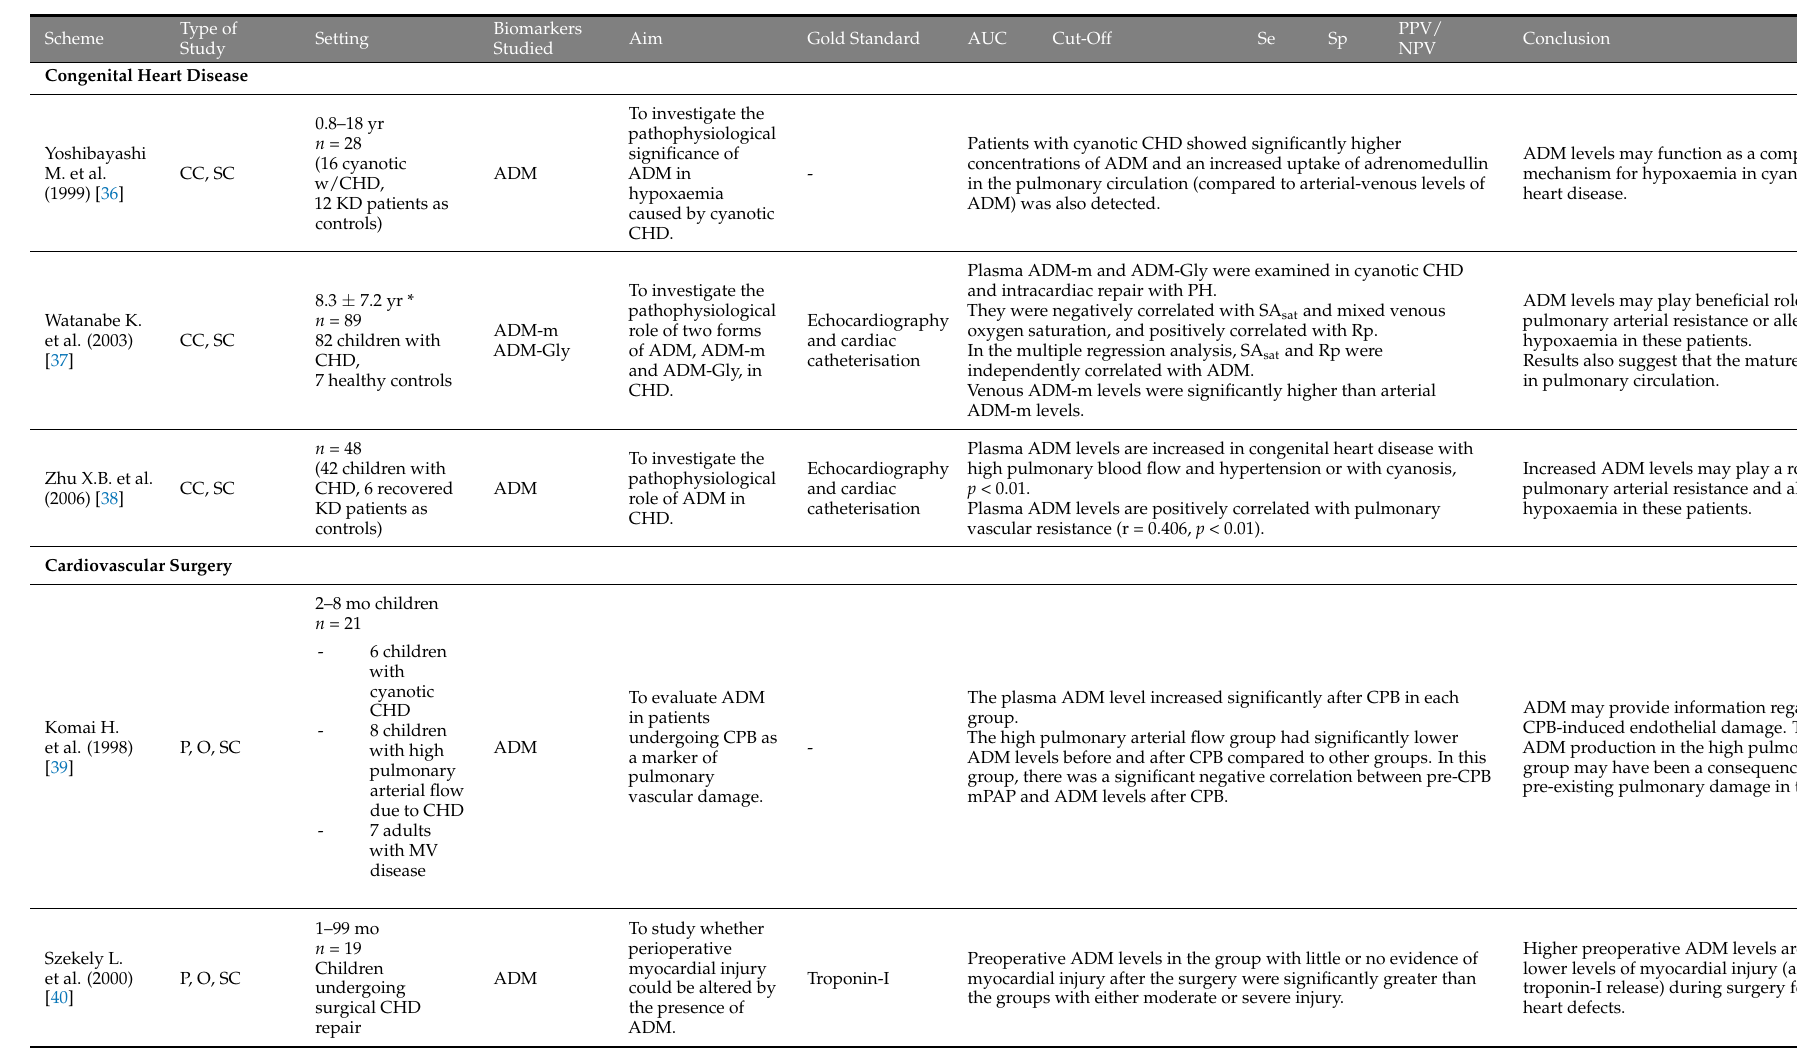
Table 2. Adrenomedullin and cardiovascular